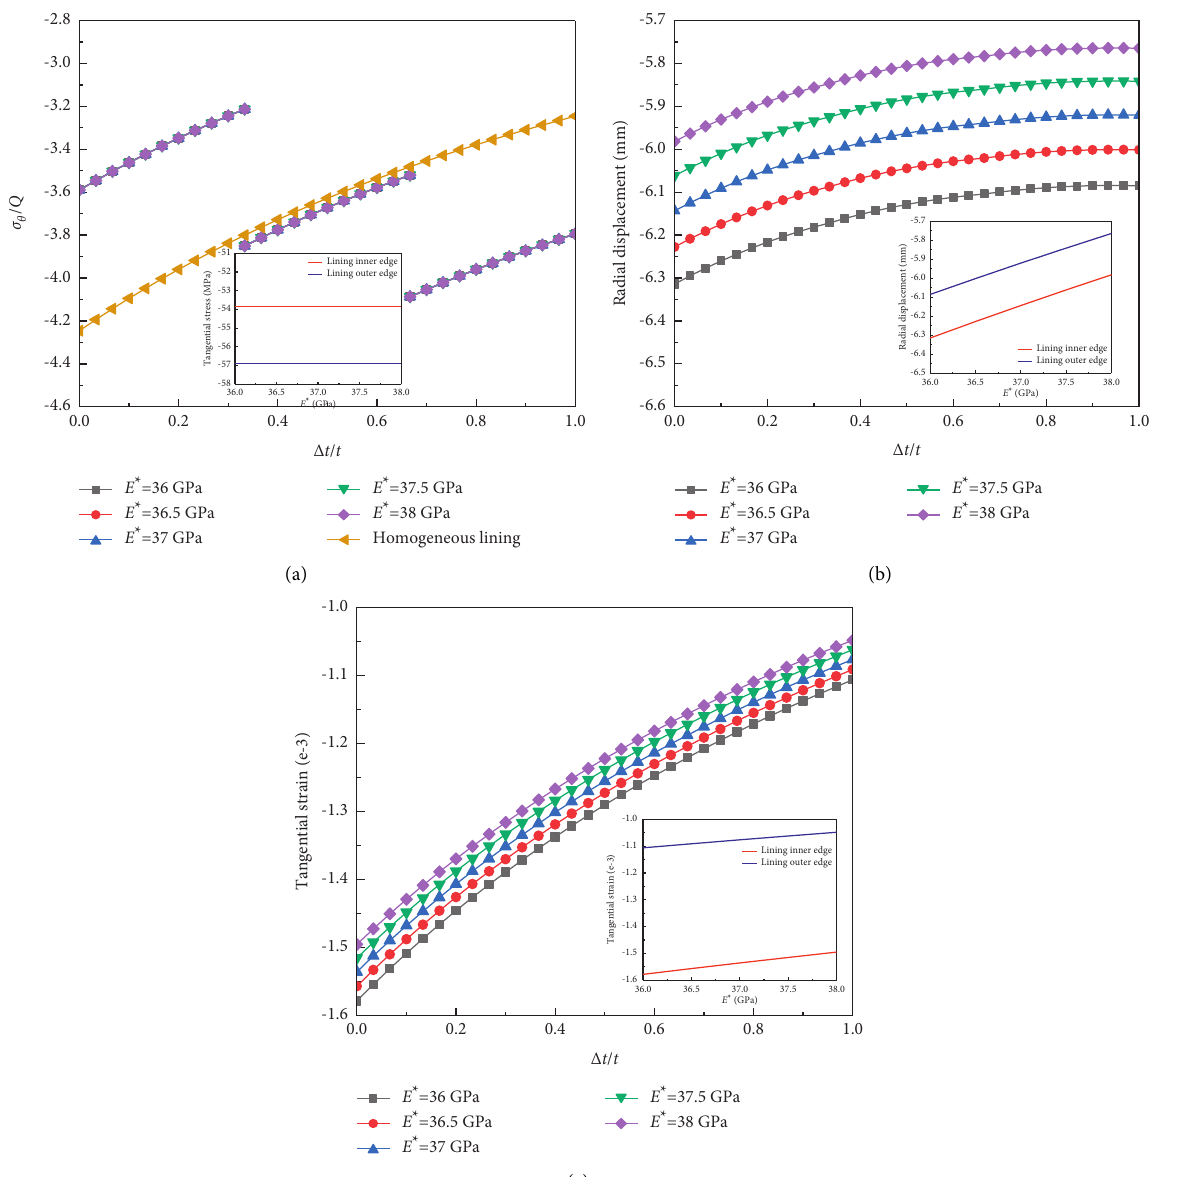
Figure 5: Variations in tangential stress, radial displacement, and tangential strain of FGL with Young’s modulus E ∗ (a) Tangential stress. (b) Radial displacement. (c) Tangential